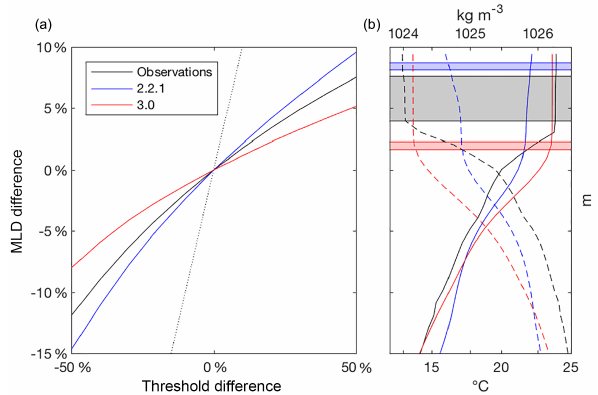
Figure 8. (a) Mean difference in the calculated MLD as a result of varying the magnitude of the temperature and density thresholds. The dotted line indicates a slope of unity. (b) A typical Argo tem- perature (solid) and density (dashed) profile (location 28 ◦ S, 96 ◦ E), with the corresponding model estimates. The relative sensitivity of each dataset is indicated by the range of MLD estimates